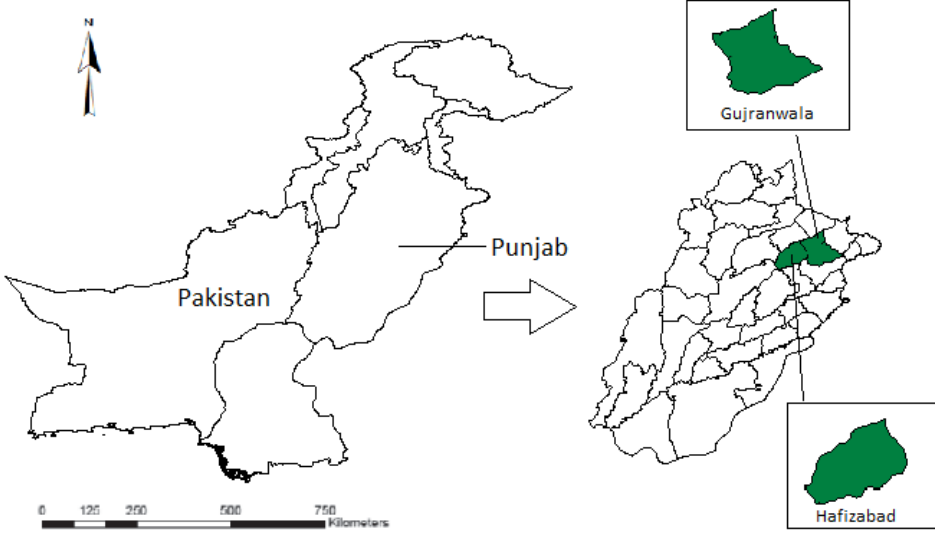
Figure 2. Location of selected study site of Gujranwala District and Hafizabad District in